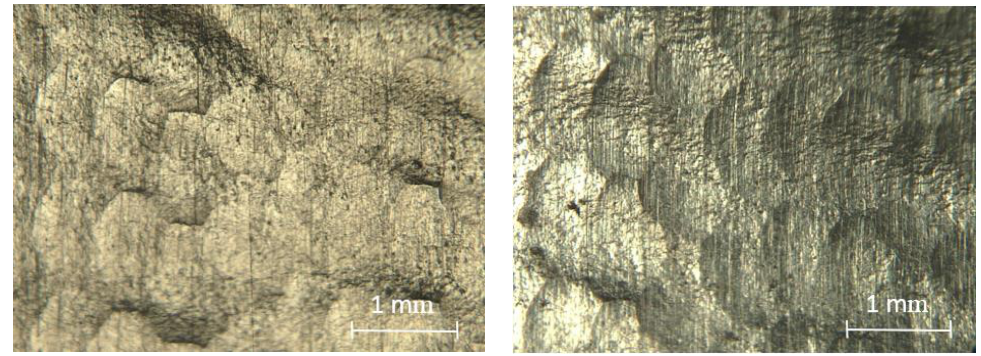
Figure 15. Deformed surface with hammering details for part D 95 H 45 α 50Δ z 0.5.